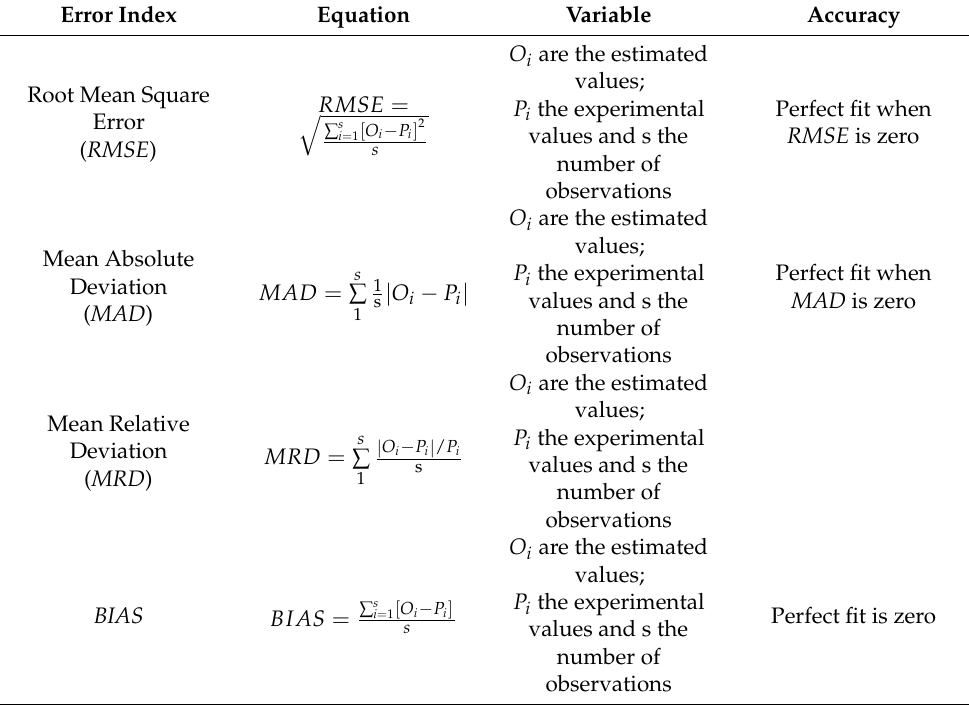
Table 4. Error indexes used in the